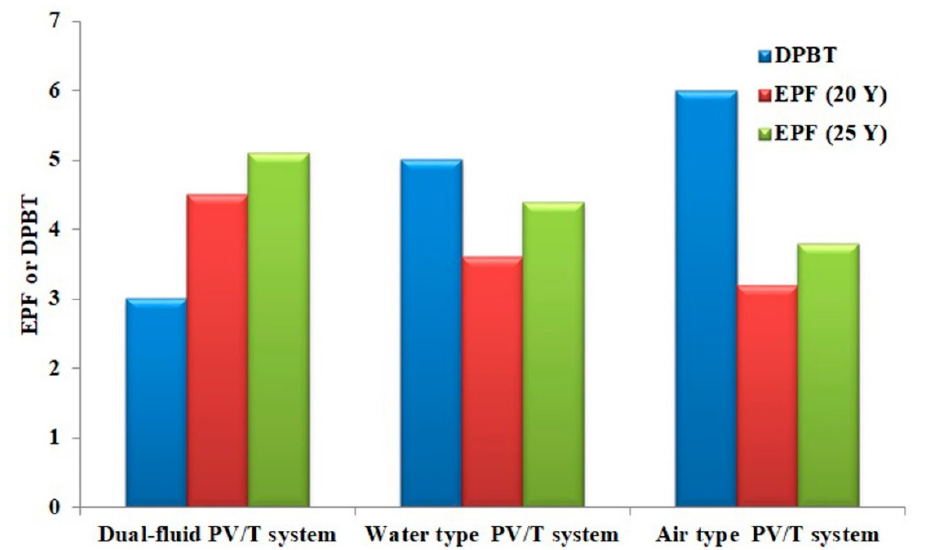
Figure 12. Energy production factor (EPF) and discounted payback time (DPBT) for different PV/T systems at 20 and 25 years.